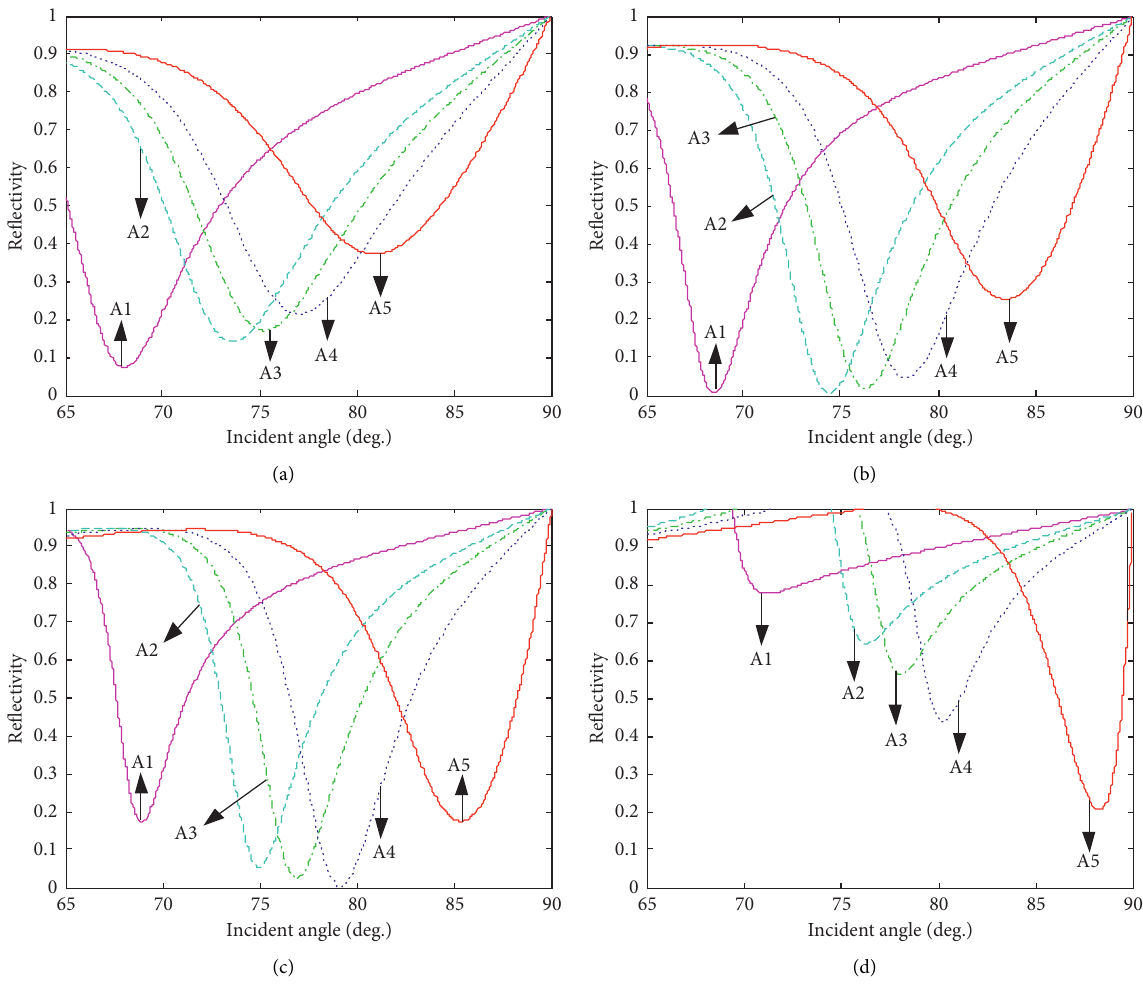
Figure 3: SPR spectrum (a) for number of GO layer L � 0, (b) for number of GO layer L � 2, (c) for number of GO layer L � 3, (d) for number of GO layer L � 4, for different refractive indices of the sensing medium layer. The curves A1, A2, A3, A4, and A5 stand for the refractive index of sensing layer n � 1.30, n � 1.32, n � 1.34, n � 1.36, and n � 1.38, respectively. And the thickness is 15nm, 10nm, 46nm, and 1 × 0.65nm for TiO 2 , ZnO, Au, and MoS 2 respectively.